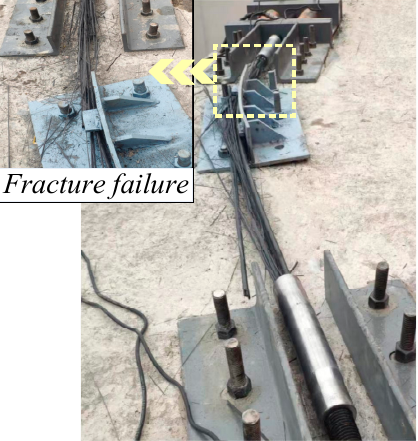
Figure 11. Failure in CFRP cable tests.